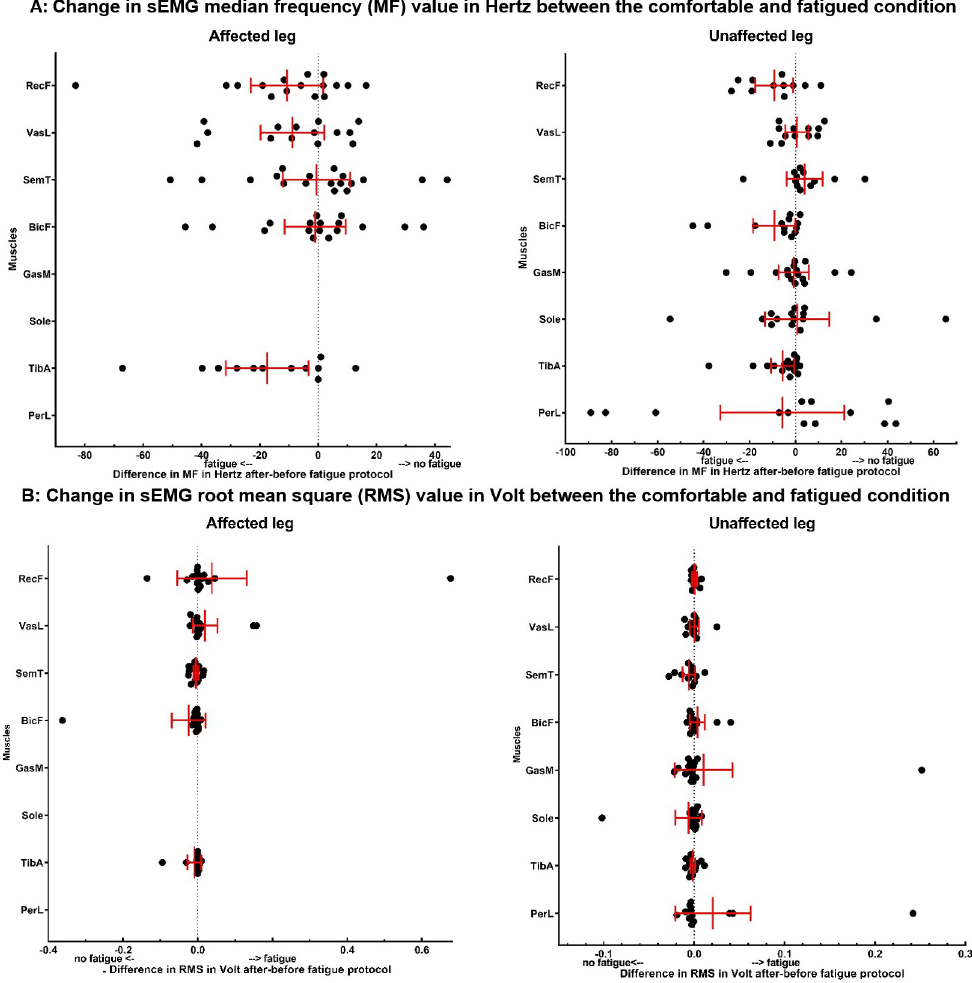
Fig 2. Changes in sEMG median frequency (MF, panel A) and root mean square (RMS, panel B) between the comfortable and fatigued condition; for the affected leg (graphs on the left) and unaffected leg (graphs on the right). The change is calculated as the difference between the value after the fatigue protocol minus the value before the fatigue protocol per muscle per patient and displayed on the x-axis. The y-axis shows the different muscles. Abbreviations used : RecF : rectus femoris; VasL : vastus lateralis; SemT : semitendinosus; BicF : biceps femoris; GasM : gastrocnemius; Sole : soleus; TibA : tibialis anterior; PerL : peroneus longus